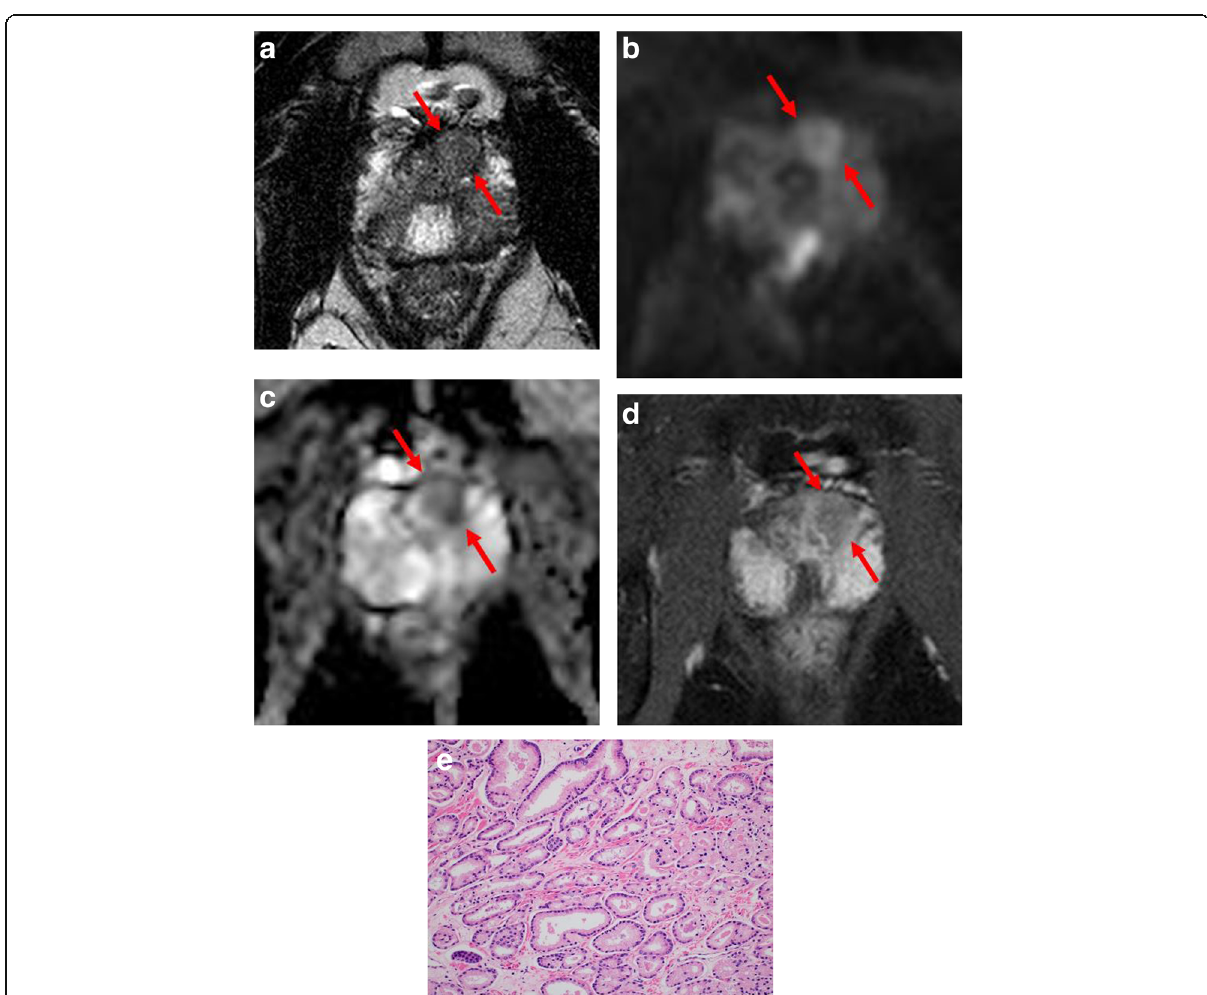
Fig. 3 Multiparametric magnetic resonance image of a 60-year-old patient who underwent radical prostatectomy (serum prostate-specific antigen 4.1 ng/ml, apparent diffusion coefficient [ADC] 0.887). An axial T2-weighted image (T2WI) ( a ) and dynamic contrast-enhanced image ( b ) indicate an approximately 1 cm, heterogeneous, obscured, marginated nodule with minimal enhancement in the left transition zone (arrows), resulting in a T2WI score of 3. Diffusion-weighted imaging (DWI) ( b = 1000) ( c ) demonstrated high signal intensity at the corresponding nodule with low signal intensity on an ADC map ( d ), resulting in a DWI score of 4. This lesion was categorized as 3 according to PI-RADS v2.1 but as 3B according to PI-RADS v2.1-B. The patient underwent radical prostatectomy, which confirmed transition-zone cancer with a Gleason score of 7 (4 + 3). The procedure revealed multiple poorly formed glands with peripherally arranged nuclei and a macronucleolus ( e